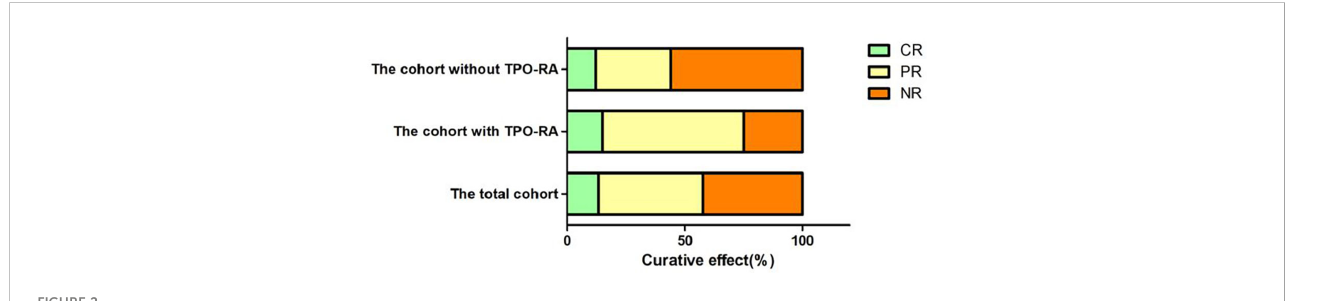
FIGURE 2 The response rate at different groups of aplastic anemia